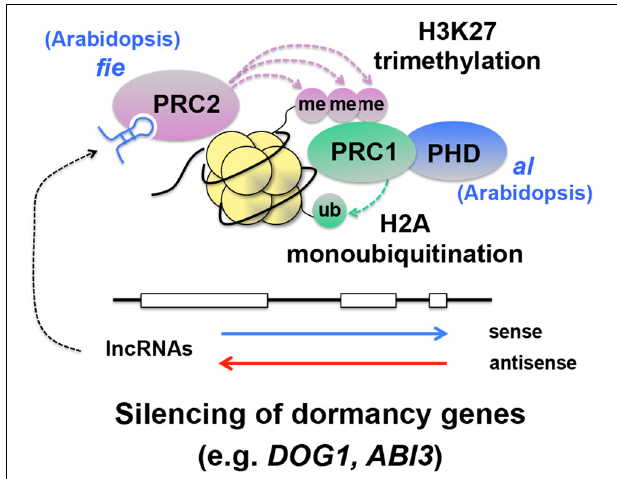
FIGURE 9 | Positive feedback loops in ABA biosynthesis in seeds. (A) In Positive Feedback 1, ABA produced by NCED, a rate-limiting ABA biosynthesis enzyme, induces ABIs. ABI3, and ABI5 interacts with each other while ABI4 induces ABI5 by binding its promoter region. ABI5 binds to the promoter region of a DELLA gene, such as RGL2, and up-regulates its expression. DELLA then promotes expression of XERICO , which increases ABA biosynthesis through unknown mechanism(s). In this way, the originally produced ABA in seeds enhances ABA biosynthesis through positive feedback. (B) In Positive Feedback 2, ABI5 down-regulates GA3ox , a GA biosynthesis gene, and reduces GA and GA response by GID1, a GA receptor. Reduced GA levels stabilize DELLA protein, such as RGL2, and increases ABA biosynthesis through XERICO , as described above. (C) In Positive Feedback 3, ABI4 up-regulates GA2ox , a GA deactivation gene, resulting in the same outcome as Positive Feedback 2. (D) ABI4 down regulates CYP707A , an ABA deactivation gene. Therefore, ABA starts to accumulate in seeds, which further enhances the same pathway through positive feedback. In these schemes, many other components, which may be participating in the pathways, and negative feedback loops are omitted. ABI, ABA INSENSITIVE; CYP707A , CYTOCHROME P450 707A ; DELLA, D (aspartic acid) E (glutamic acid) L (leucine) L (leucine) A (alanine) protein; GA, gibberellin; GA2ox; GA 2-oxidase; GA3ox, GA 3-oxidase; GID1, GA INSENSITIVE DWARF; NCED, nine- cis -epoxycarotenoid dioxygenase; RGA, REPRESSOR OF GAI; RGL2, RGA-LIKE 2; XERICO, “XERICO” (Greek for drought tolerant). The schemes are based on Ko et al. (2006), Zentella et al. (2007), Ariizumi et al. (2008), Piskurewicz et al. (2008), Bossi et al. (2009), Lee et al. (2012b), Cantoro et al. (2013), Kong et al. (2013), Lim et al. (2013), and Shu et al.